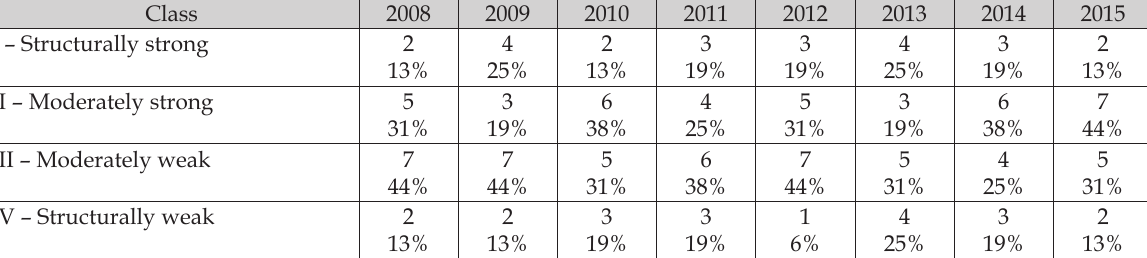
Table 6. Number and percentage of rural regions in each class for Portugal, 2008–2015